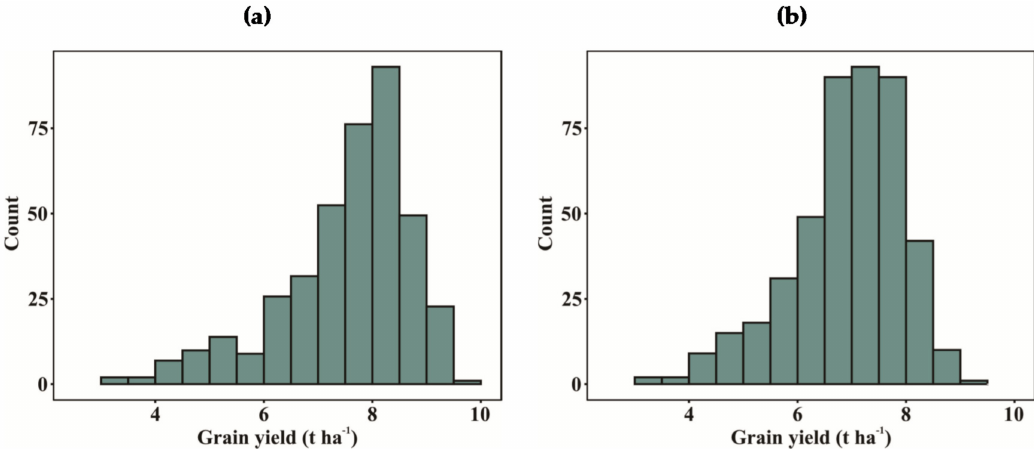
Figure 4. Grain yield distribution under ( a ) full irrigation treatment; ( b ) limited irrigation treatment. The heritability (H 2 ) was high in the mid-grain filling stage, which ranged from 0.60 to 0.91 for all VIs (Tables A1–A4). The VIs with heritability values greater than 0.5 were selected as the input features for the model to make grain yield prediction for wheat in a particular growth stage. Under full irrigation treatment, the numbers of VIs with a heritability value greater than 0.5 were 17, 14, 18, and 20 for heading flowering EGF and MGF, respectively, and the the numbers of VIs with a heritability value greater than 0.5 under limited irrigation treatment were 19, 19, 18, and 20 across growth stages (Figure